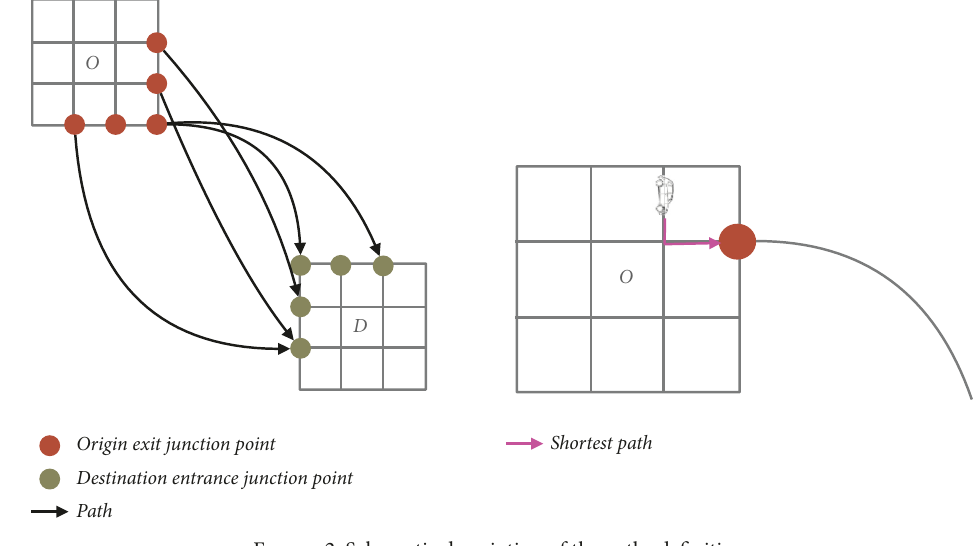
Figure 2: Schematic description of the paths